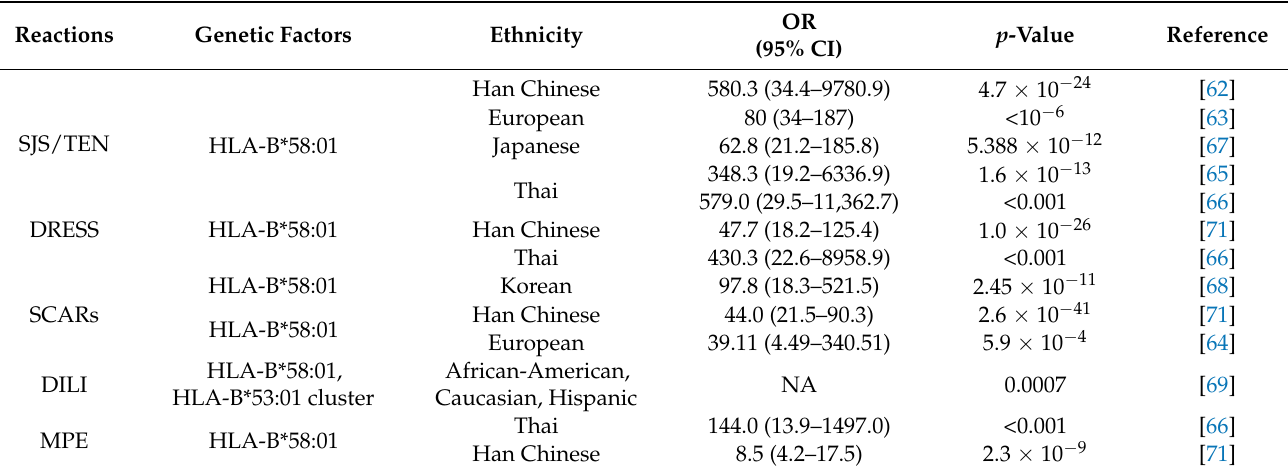
Table 3. Genetic variants associated with allopurinol-induced hypersensitivity